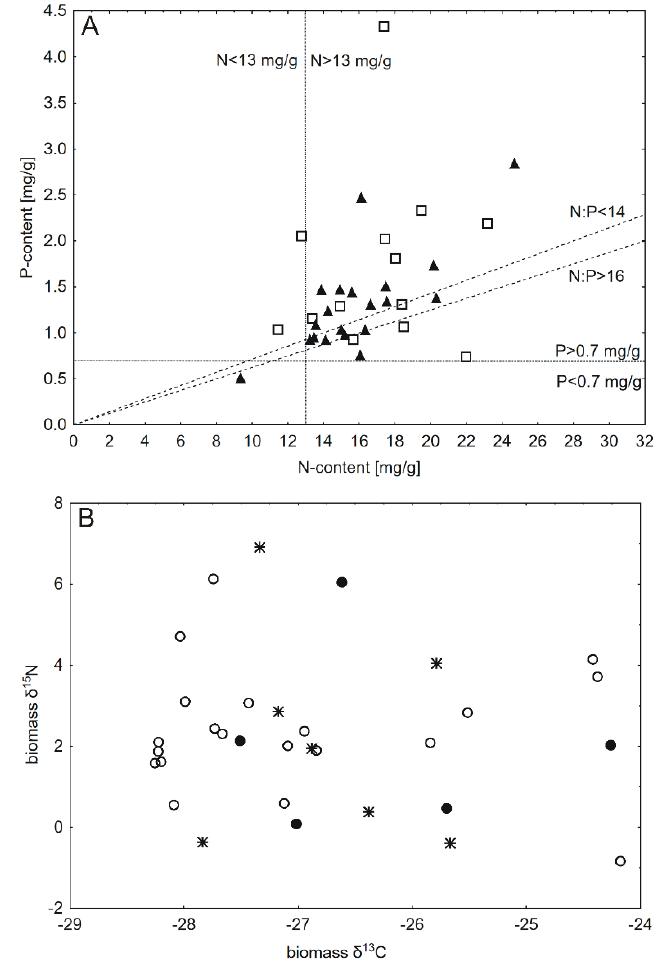
Figure 5. A: Relationship between vegetation TN and TP content and the nature of nutrient limitation in salt marsh with Blysmus rufus (squares) and small sedge meadow with Carex species (triangles). Dashed lines depict N/P quotients of 14 and 16, by mass (as in Koerselman & Meuleman 1996); dotted lines depict N and P contents of, respectively, 13 mg g -1 and 0.7 mg g -1 (as in Wassen et al. 1995). B: Relationship between δ 15 N and δ 13 C in biomass samples according to limitation type, following Koerselman & Meuleman (1996). Unfilled circles denote N limitation, filled circles denote P limitation, and asterisks denote N and P limitation or no